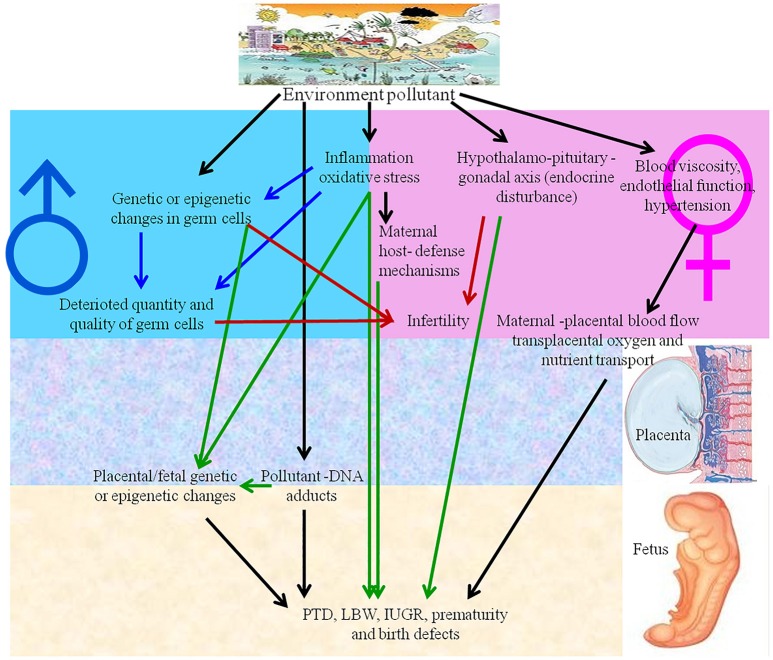
Environmental pollutants and nanoparticles have adverse effects on human reproduction. IUGR, intrauterine growth retardation; LBW, low birth weight; PTD, preterm delivery.